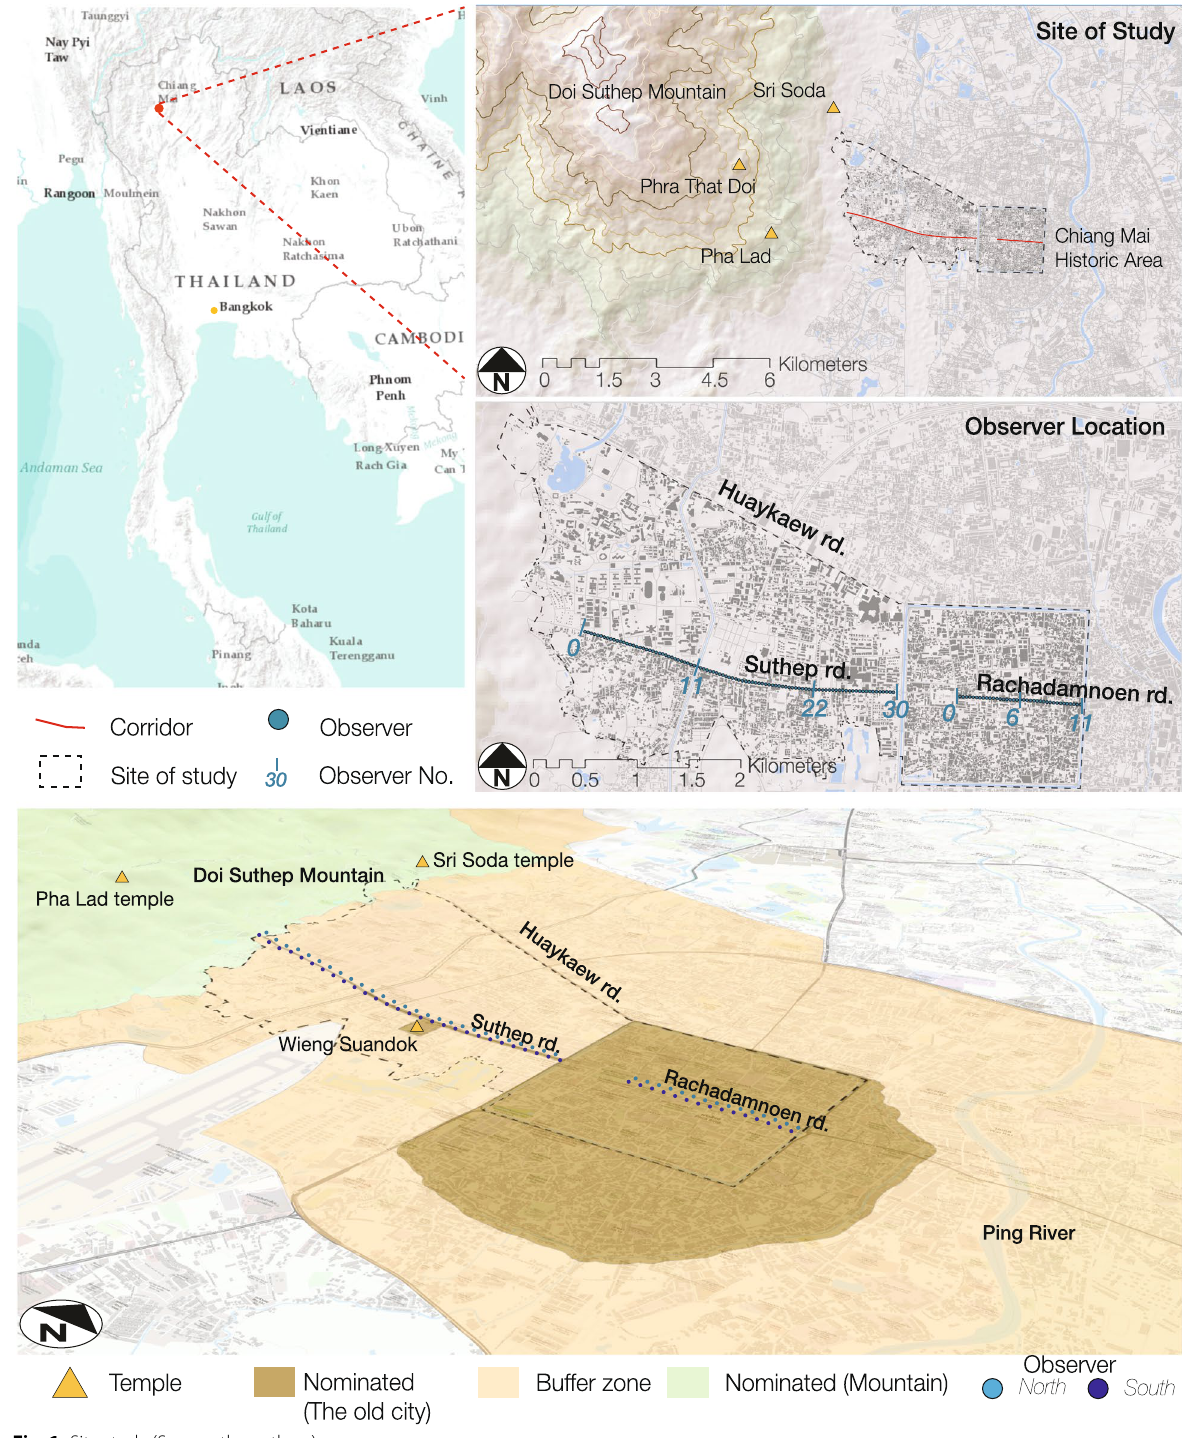
Fig. 1 Site study (Source: the